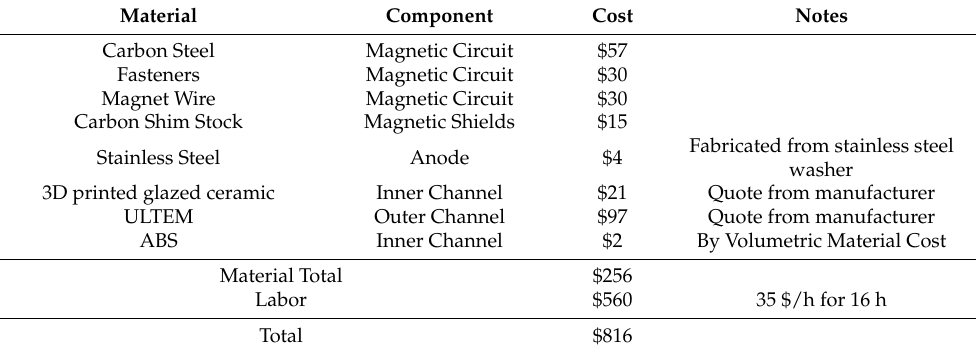
Table 1. UAH-78AM cost